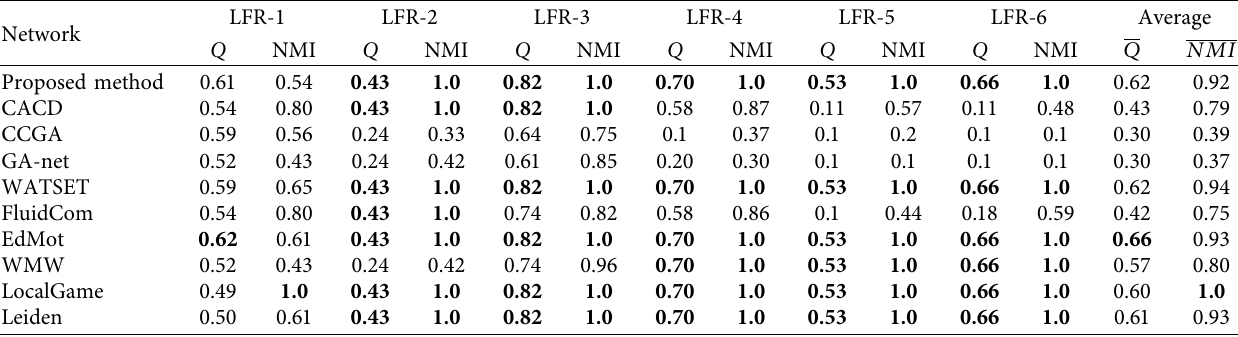
Table 5: Comparison of the results of synthetic networks of the proposed method with other methods based on NMI and modularity ( Q )